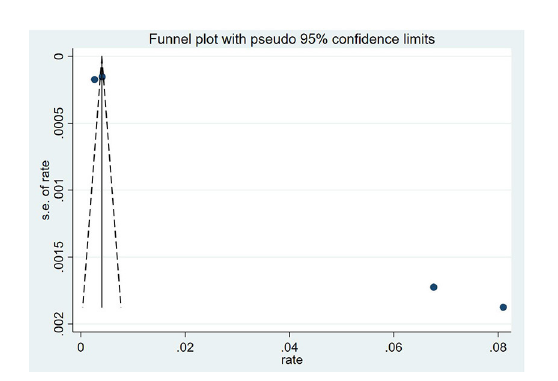
FIGURE2 Funnel figure showing the prevalence of hospital–wide